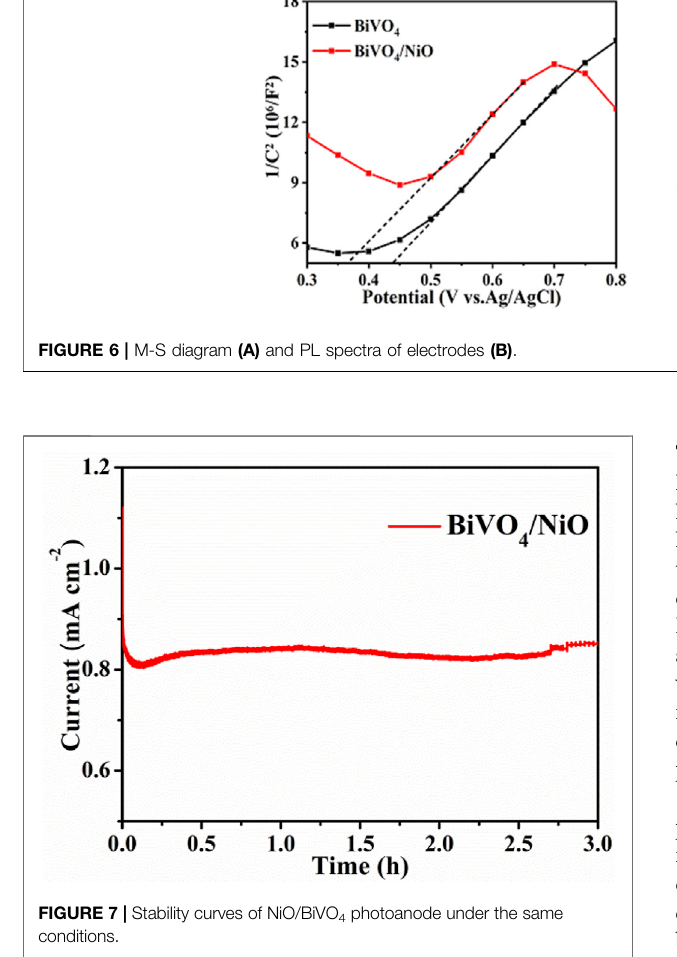
Frontiers in Chemistry |